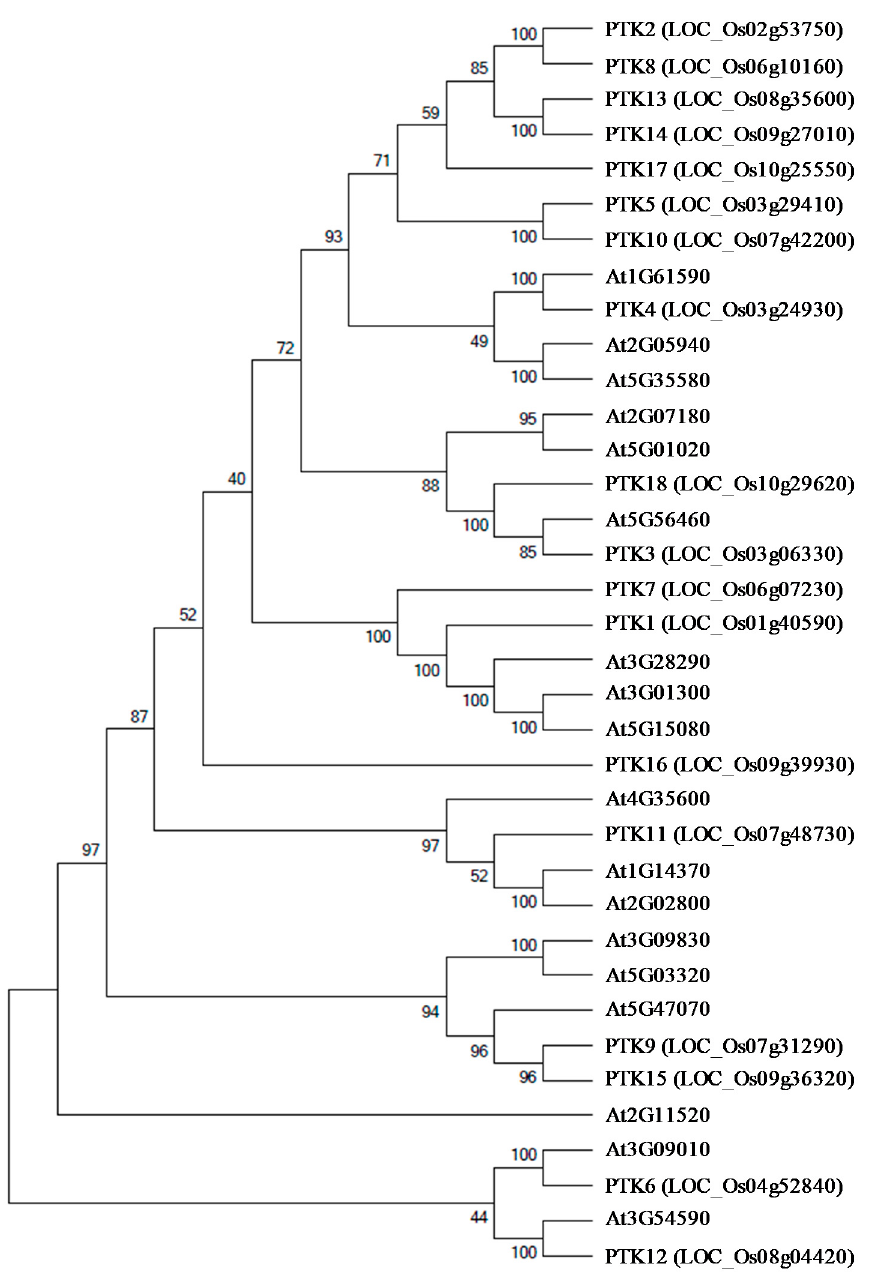
Figure 4. Phylogenetic analysis of OsPTK and AtPTK protein sequences. The unrooted phylogenetic tree was constructed using Molecular Evolutionary Genetics Analysis software version 7.0 (MEGA7). The amino acid sequences were aligned using the Clastalw and Neighbor joining analysis was performed with the pairwise deletion option with Poisson correction, bootstrap analysis was conducted with 1000 replicates. The digits on branches indicate boot strap values.